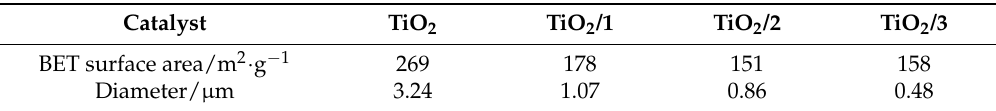
Figure 5. SEM images of titania ( 1 ), the composites TiO 2 / 1 ( 2a ), TiO 2 / 2 ( 3a ), and TiO 2 / 3 ( 4a ) and the fullerene derivates 1 ( 2b ), 2 ( 3b ), and 3 ( 4b ). Table 1. Brunauer–Emmett–Teller (BET) surface areas and diameters determined for titania and titania-based composites.